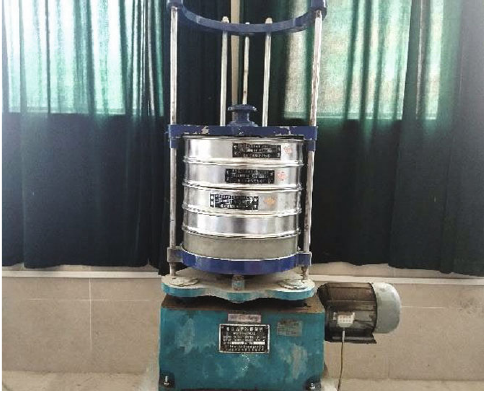
Figure 1: Screening marine soft